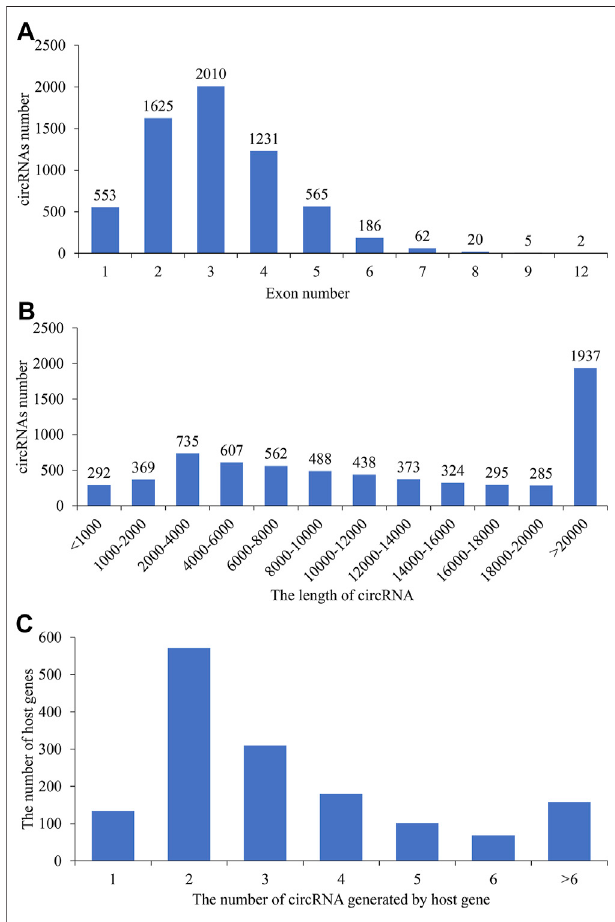
FIGURE2| Statisticsoftheexonnumberandlengthofidenti fi edcircular RNAs (circRNAs). The exon number (A) and length (B) distributions of circRNAs; (C) the number of circRNAs generated by host